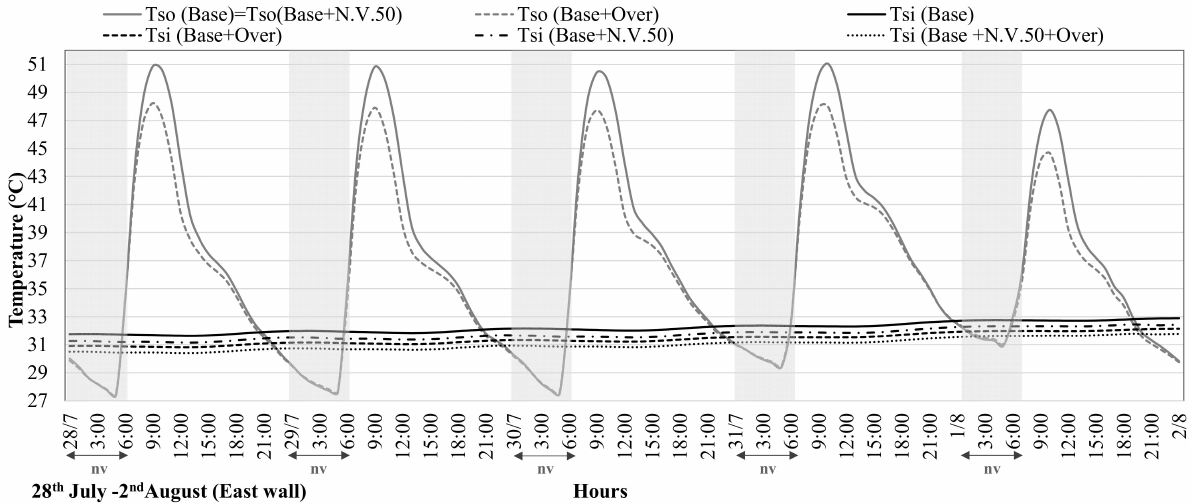
Figure 2. Outdoor surface temperature (T se ) vs. indoor surface temperature (T si ) in the investigated cases from 28 July to 2